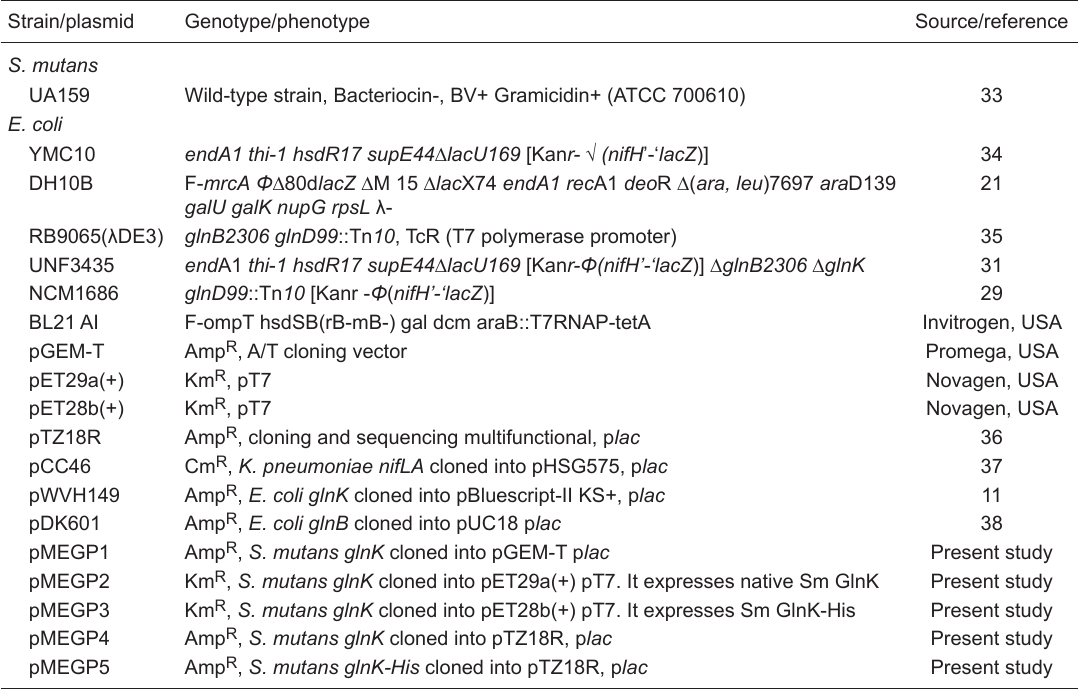
Table 1. Bacterial strains and plasmids used in this